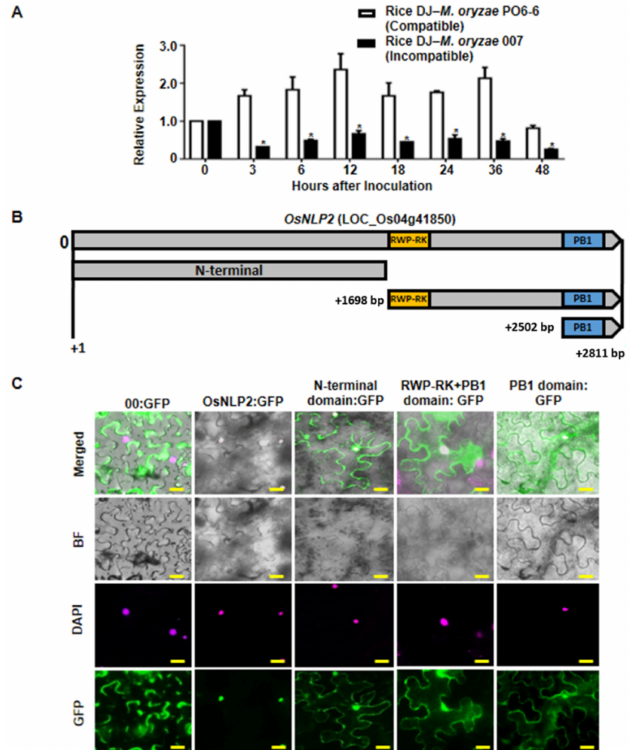
Figure 1. OsNLP2 expression pattern and subcellular localization analysis. ( A ). Real-time qRT-PCR analyses of OsNLP2 expression in leaf sheaths of rice DJ at different time points after inoculation with Magnaporthe oryzae PO6-6 (virulent) and 007 (avirulent) strains. Transcript levels of the internal control genes OsUbiquitin , 18S rRNA , and OsActin were used to normalize OsNLP2 transcript levels. Relative expression levels were determined by comparing the values at different time points with the 0 h sample values. The data are presented as means ± standard deviation (SD) of relative expression quantities of OsNLP2 in leaf sheaths from the different rice plants ( n = 4). Asterisks indicate significant differences, as determined by Student’s t -test ( p < 0.05). ( B ). Domain alignment of OsNLP2 .